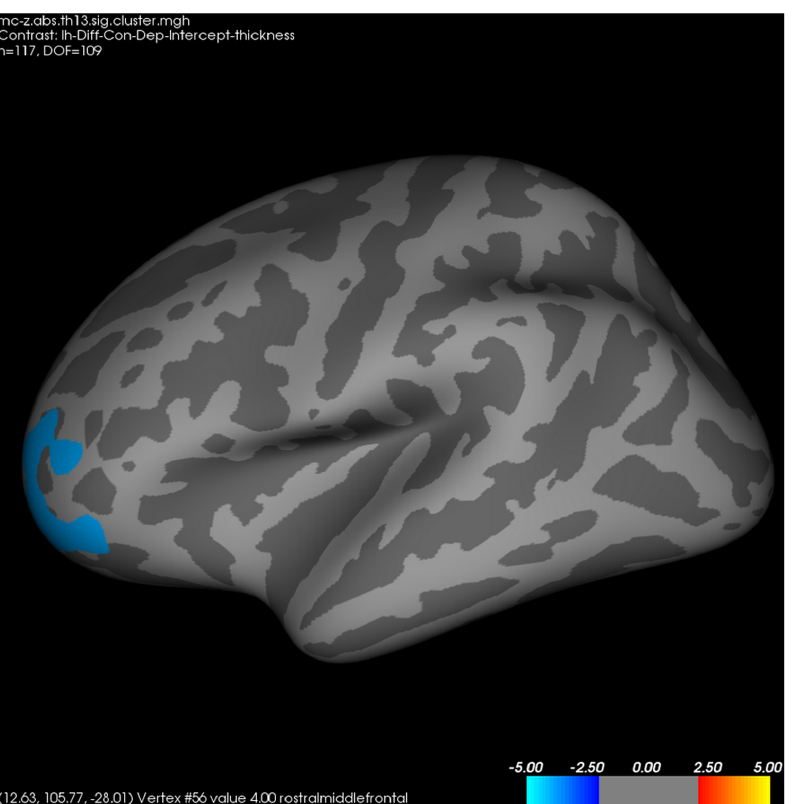
Figure 3. Differences in left cortical thickness between patients with major depressive disorder and healthy controls. FWE -corrected p , 0.05 through Monte-Carlo permutation test.